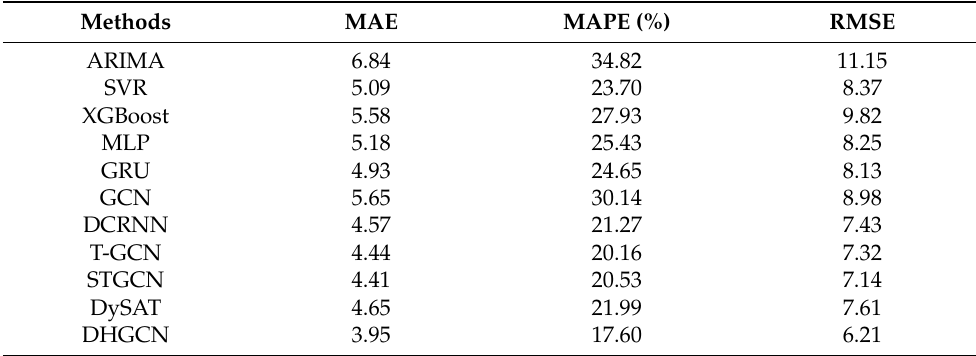
Table 1. Performance comparison of different methods.